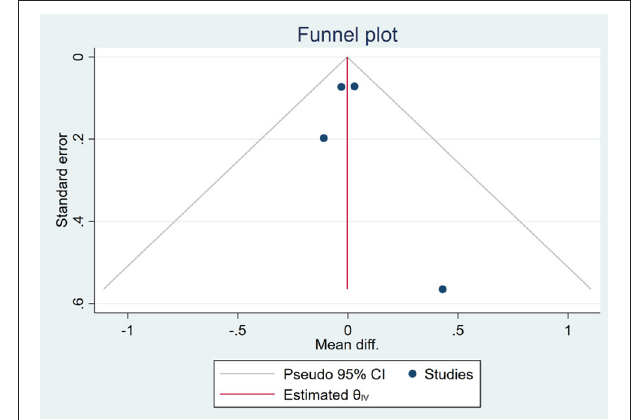
FIGURE 29 | Funnel plots of the effect of